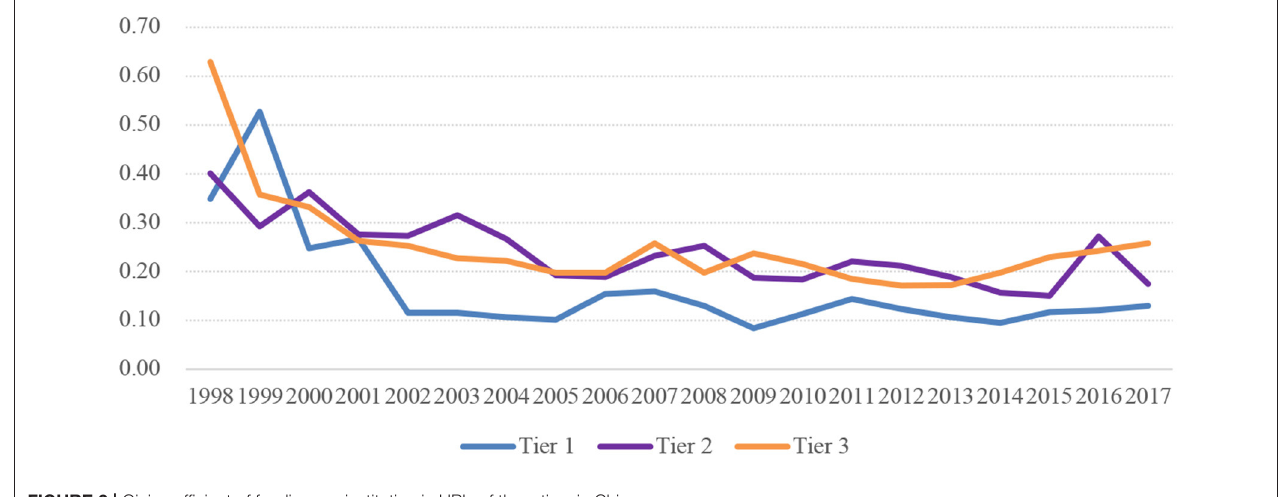
FIGURE 2 | Gini coefficient of funding per institution in HPIs of three tiers in China.